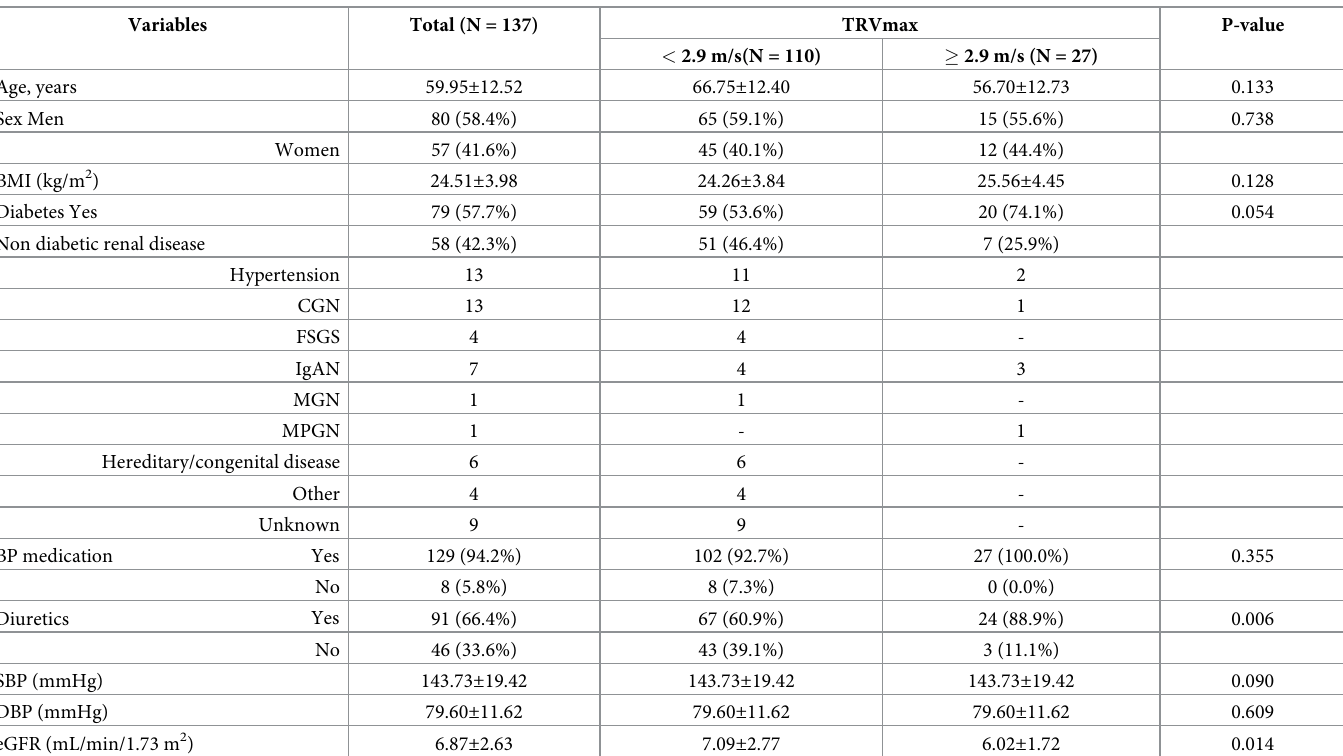
Table 1. Demographic findings of study patients.